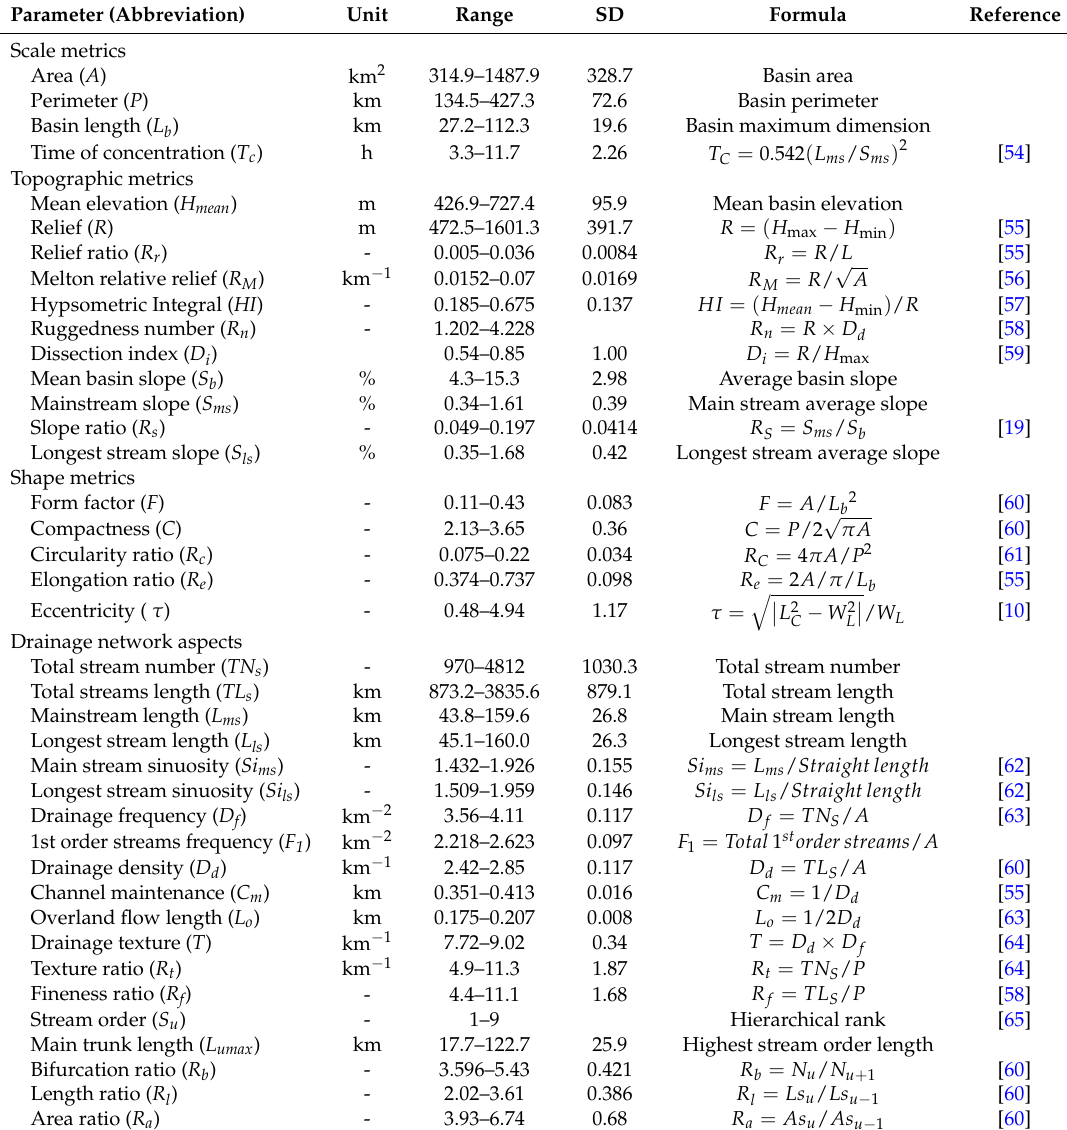
Table 1. List and description of the used geomorphometric